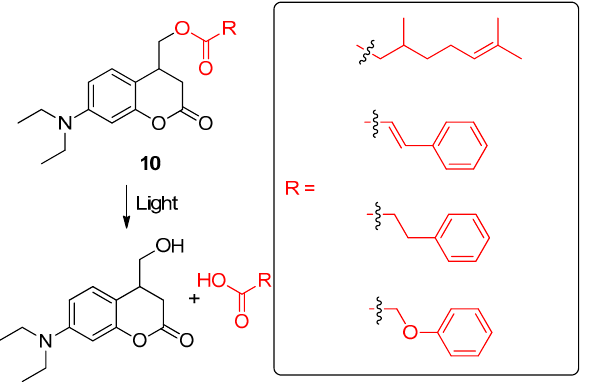
Figure 12. Photo-triggered release of carboxylic acid-based scents from coumarin-based profragrances 10 , highlighting the precursor of the scent. The fragments of the scents are included in a box. The original results were reported by Han, Zhu and coworkers